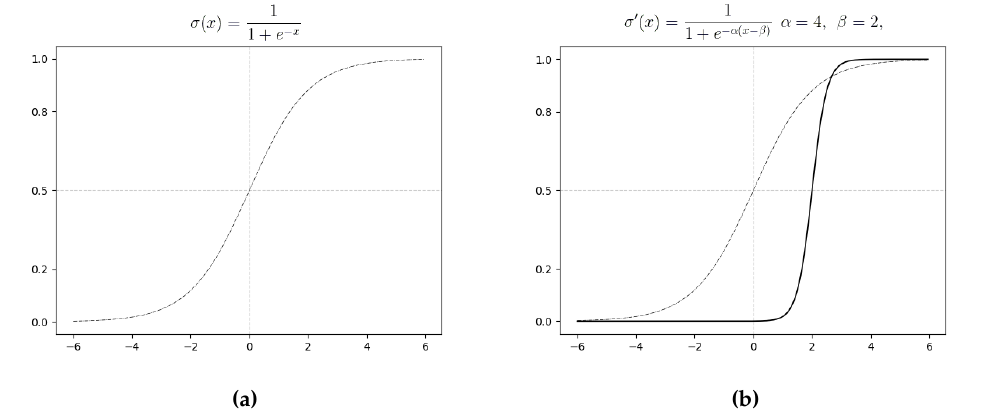
Figure 6. ( a ) Standard logistic function plot. ( b ) Generalized logistic function plot using parameters α = 4 and β = 2.